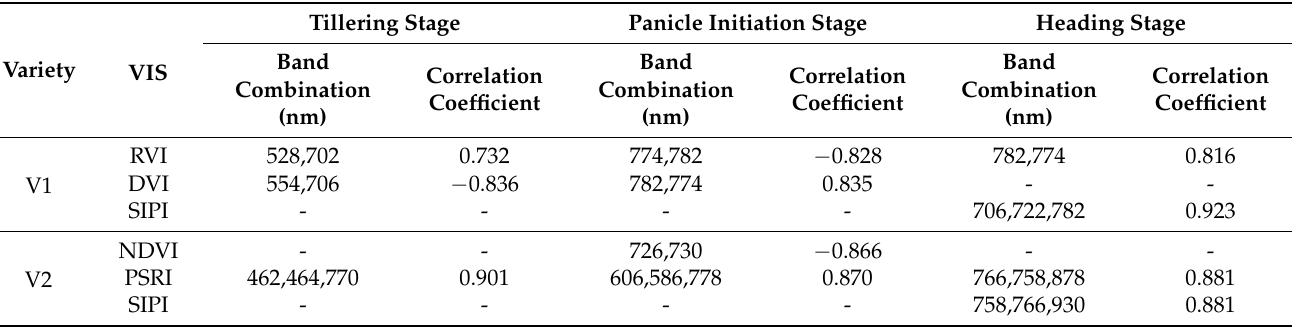
Table A3. Relationships between grain protein content (GPC) and optimal spectral indices for two rice varieties at three different growth stages ( n =